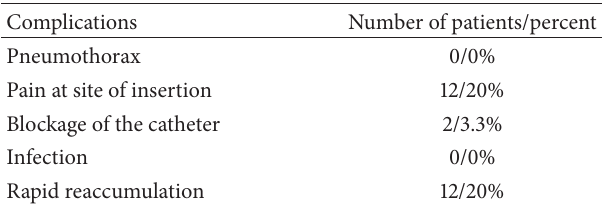
Table 2: Complications of pigtail catheter insertion.